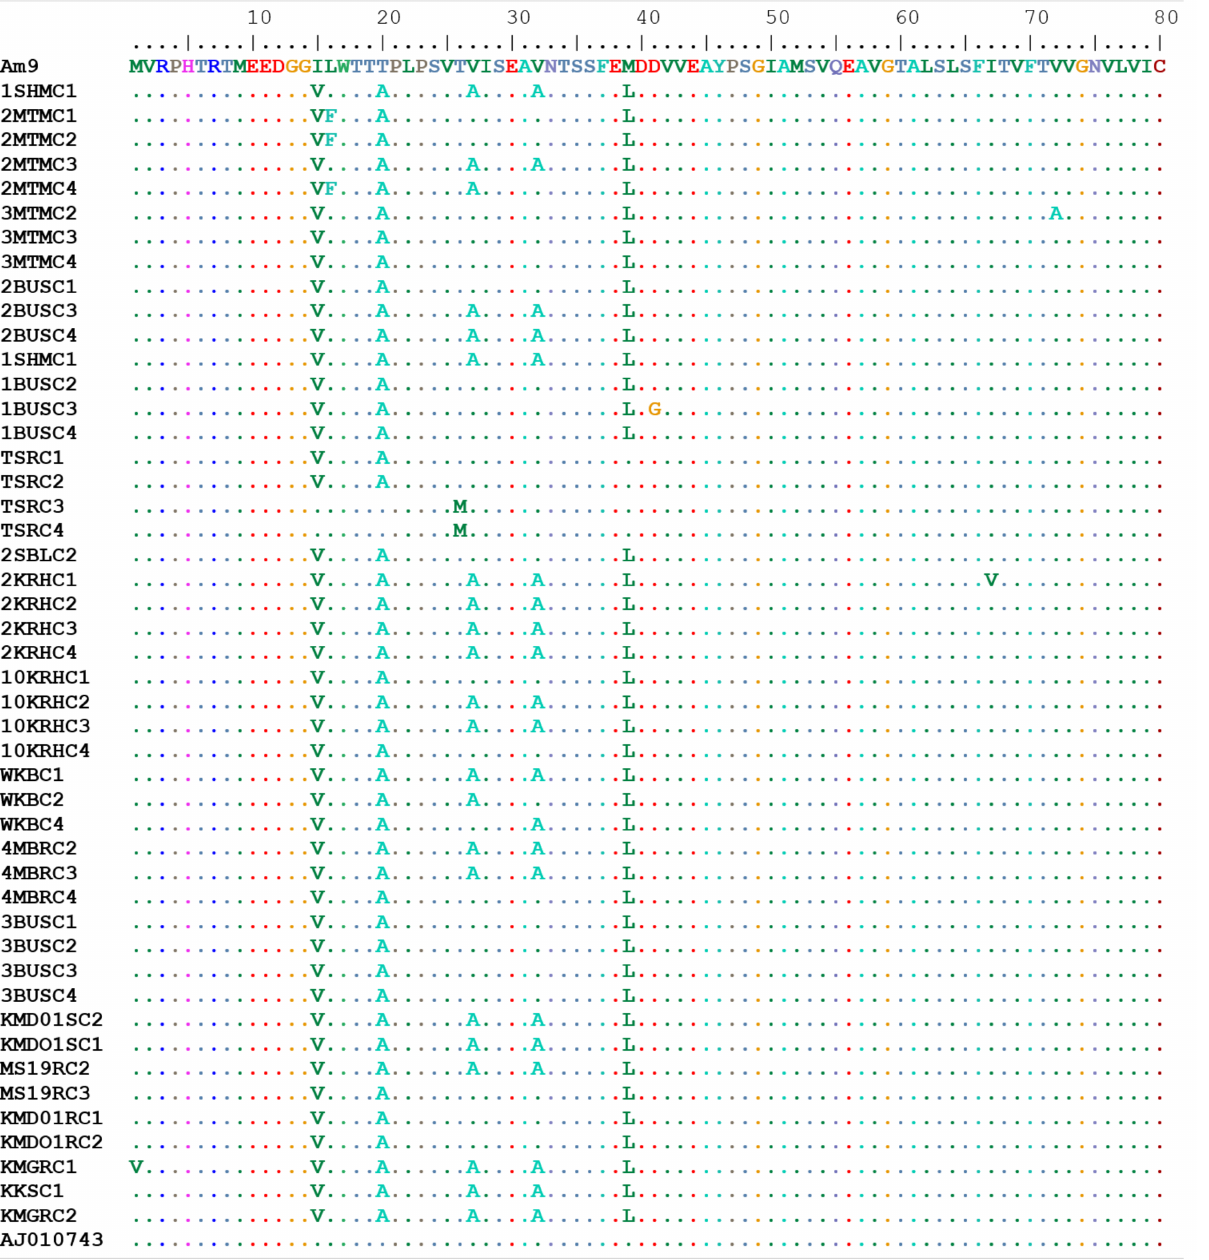
Figure 4. Multiple sequence alignment of deduced amino acid sequence for R. ( B .) decoloratus OCT/Tyr receptor gene partial coding region in amitraz-resistant and -susceptible ticks. OCT/Tyr se- quence from GenBank: AJ010743.1 (octopamine-like, G-protein coupled receptor from R. ( B .) microplus strain from Australia). Amitraz resistance was associated with M1V, F16F, D41G and V72A amino acid substitutions. AM9 to KMGRC2 identifies different clones of the OCT/Tyr gene from various tick populations